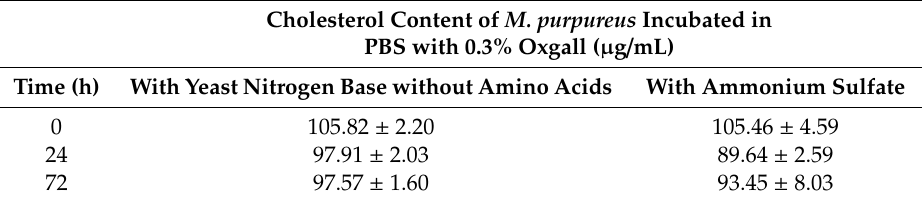
Table 4. Cholesterol content ( µ g / mL) of M. purpureus CBS 109.07 incubated in PBS with nitrogen sources. All cultures were incubated at 37 ◦ C with 120 µ g / mL cholesterol and 0.3% ( w / v ) oxgall bile salts. Cholesterol content was determined from two independent trials conducted for each growth phase at each time point, and measured in duplicate via GC-FID. All means were not significantly di ff erent from the initial value at t = 0 ( p < 0.05). Standard deviation in cholesterol content is absolute error. Cholesterol Content of M. purpureus Incubated in